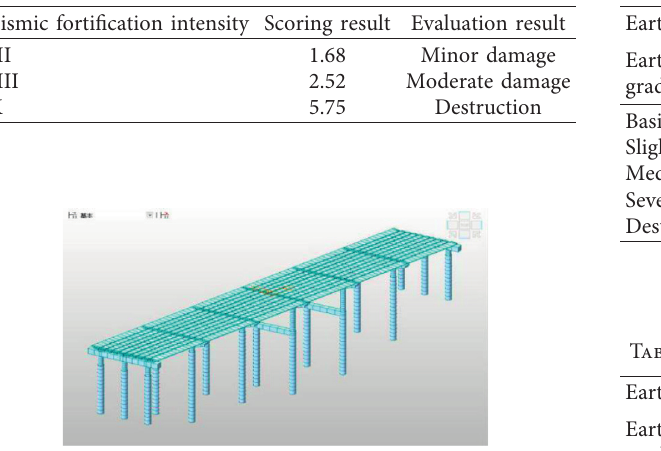
Table 9: 1 st -stage evaluation results.